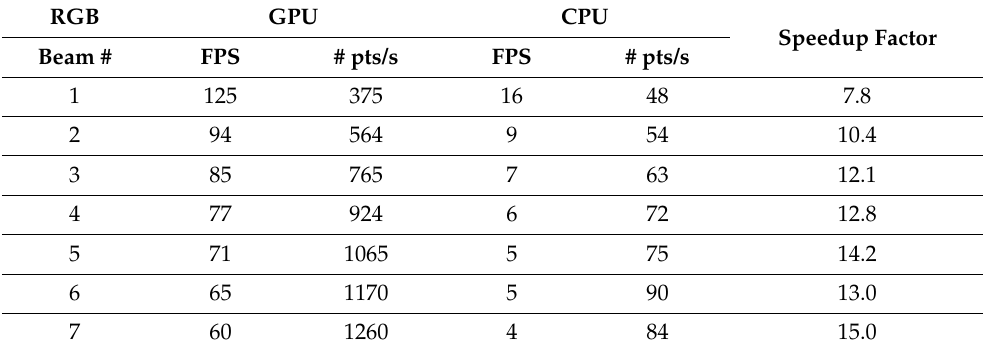
Table 2. CGH processing time for single-beam steering using a CPU and a GPU in the RGB